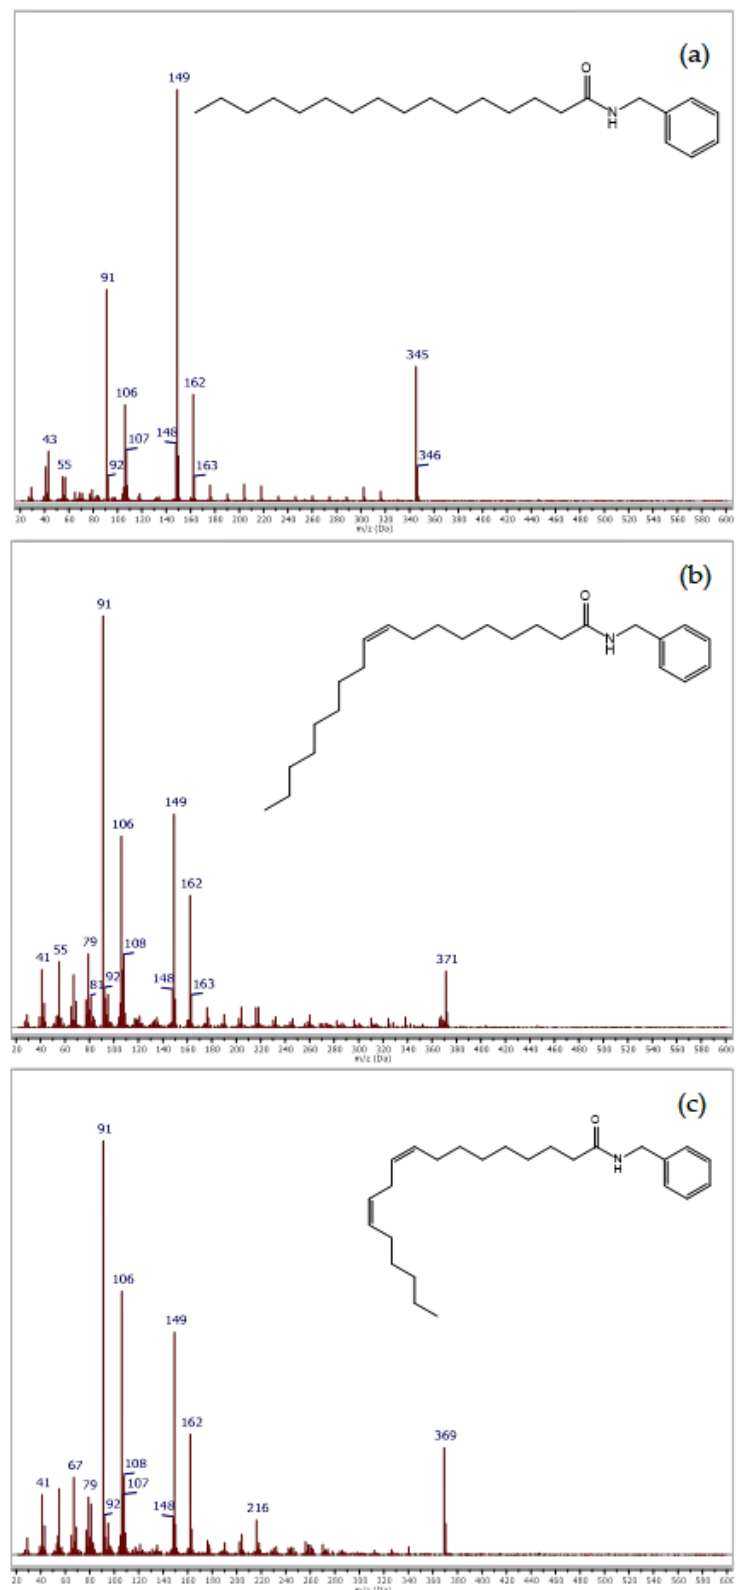
Figure 5. Mass spectra of macamides: N -benzylhexadecanamide ( a ), N -benzyl-(9Z)-octadecenamide ( b ), and N -benzyl-(9Z,12Z)-octadecadienamide ( c ), identi fi ed in ethanolic extracts of maca ( L. meyenii ) root.